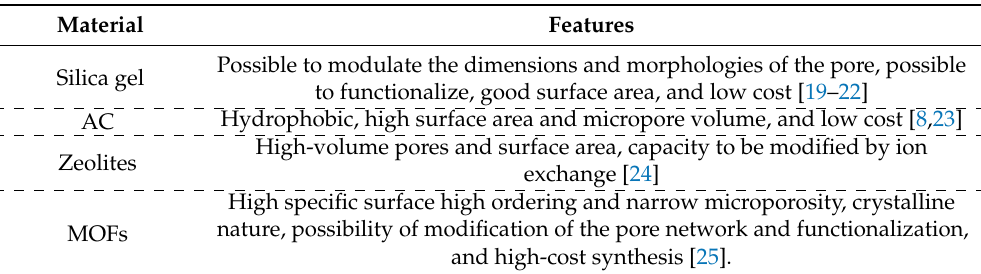
Table 1. Some advantages of silica gel, activated carbons (AC), zeolites, and Metal Organic Frame- works (MOFs) as